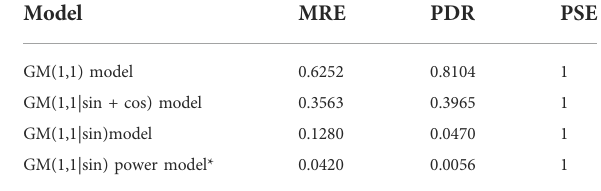
TABLE 10 Evaluation metrics of grey models in